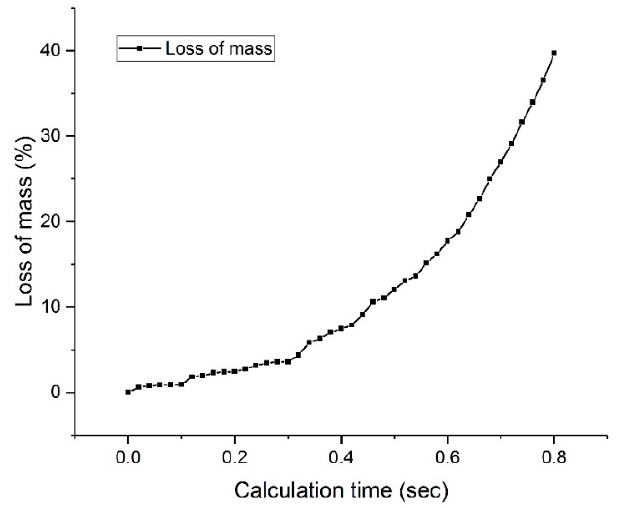
Figure 22. Mass-loss measurement.